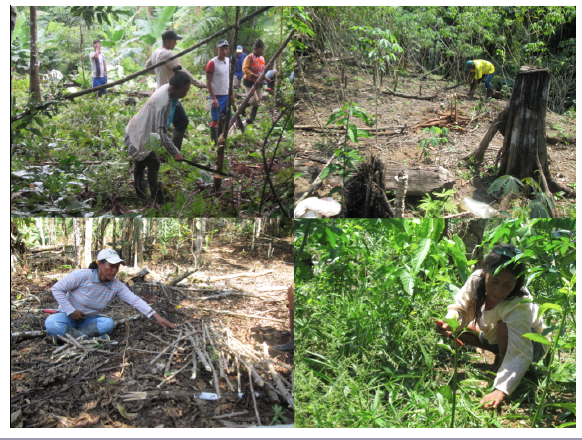
Fig. 1 . Land clearing, seed selection, tending, and